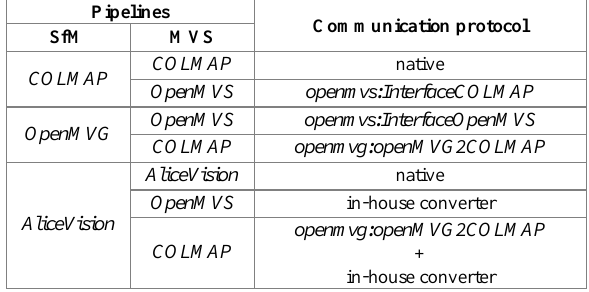
Table 1: The employed pipelines and combined